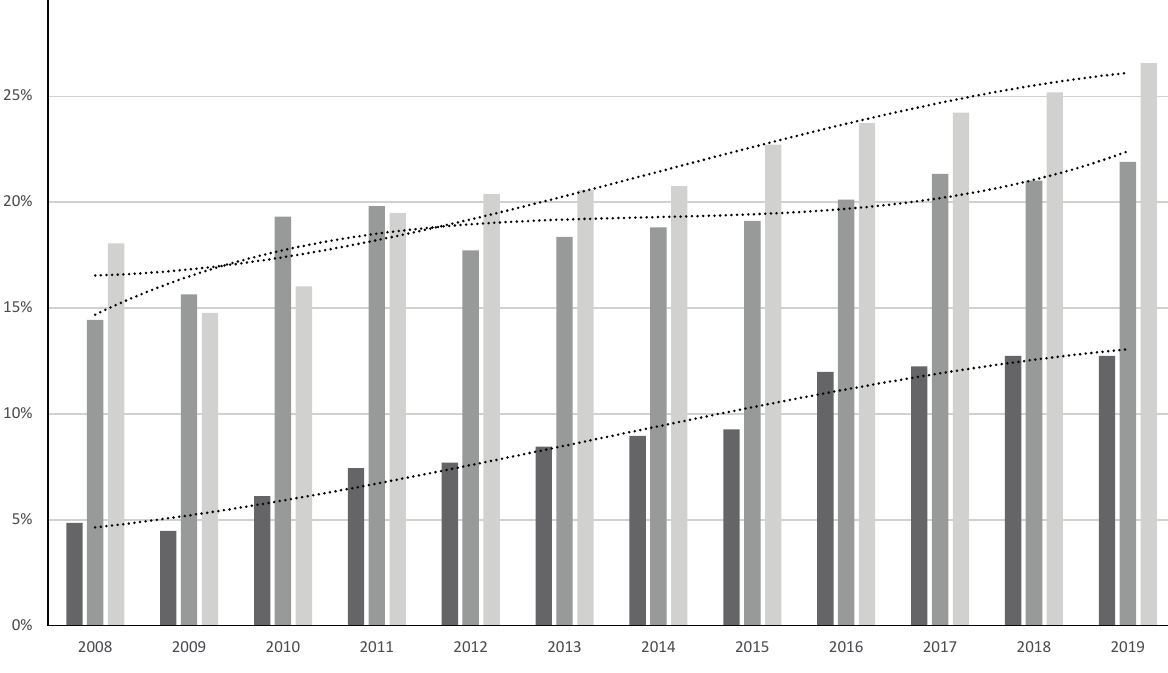
Figure 13. Evolution of the share of farms with certifications within the Italian 2008-2019 FADN balanced